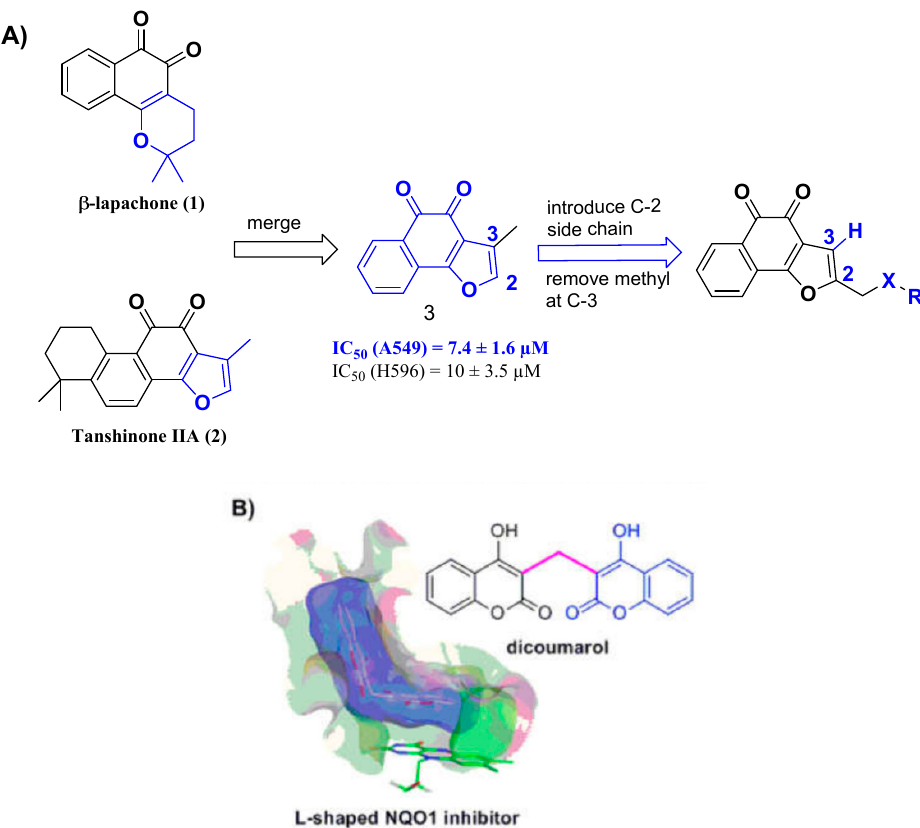
Figure 1. ( A ) Structural design strategy and ( B ) l -shaped pocket. The figure is available in reference